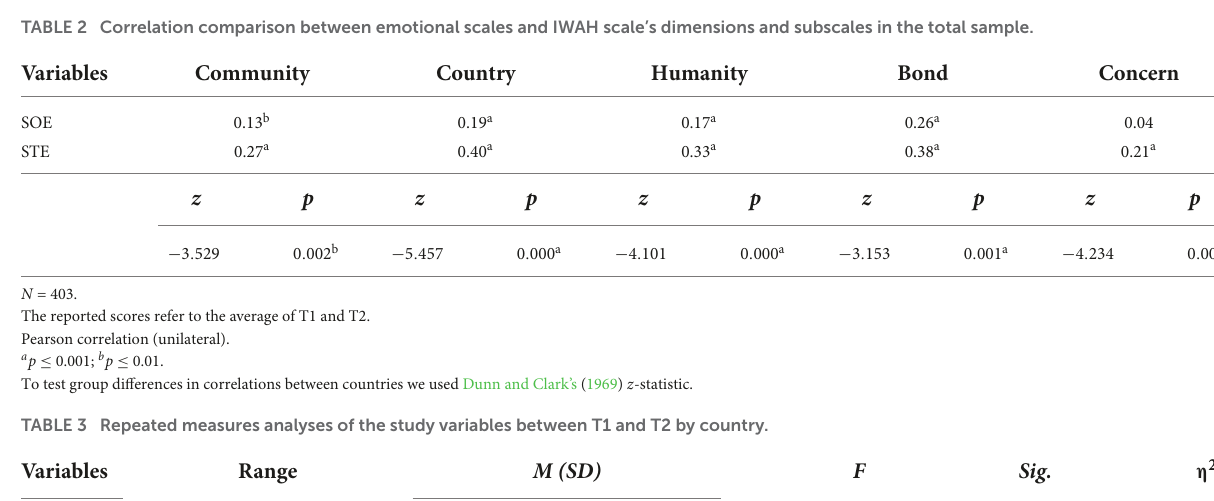
TABLE 2 Correlation comparison between emotional scales and IWAH scale’s dimensions and subscales in the total sample. Variables